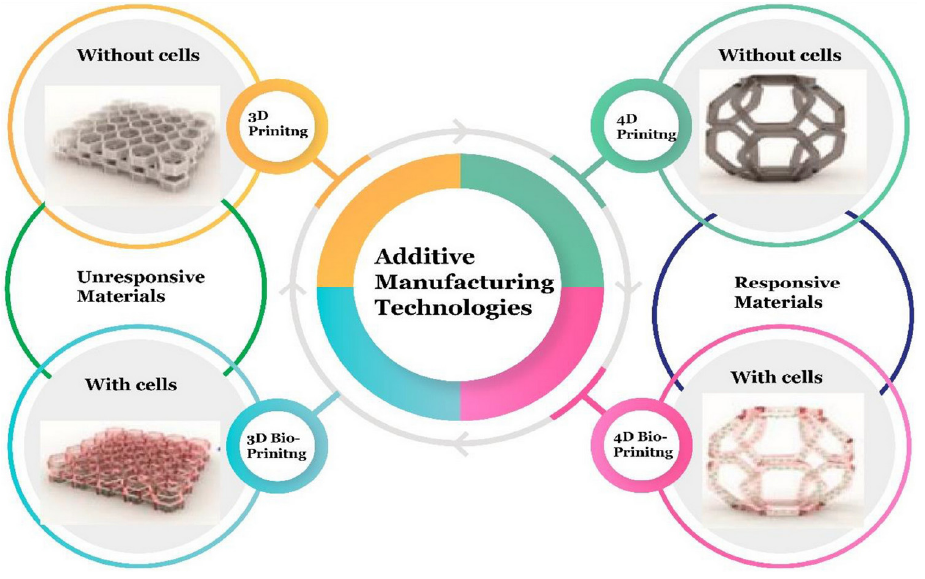
Figure 11. Conceptual difference between 3D and 4D printing [78].